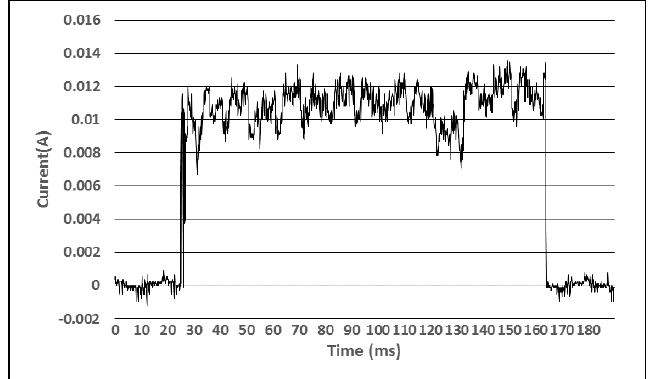
Figure 5. Consumption profile during one active interval (T, RH, light, and battery level measurement).